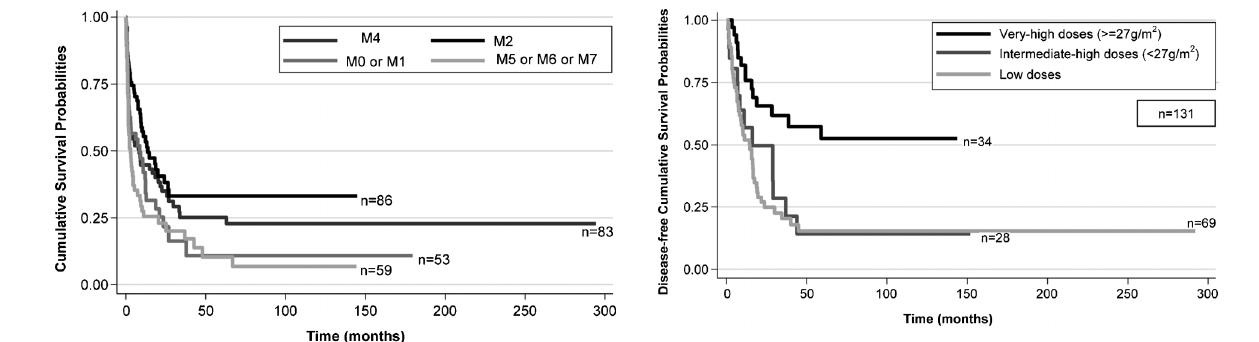
Figure 2. Overall survival, by French-American-British (FAB) classification (P=0.003, log-rank test).